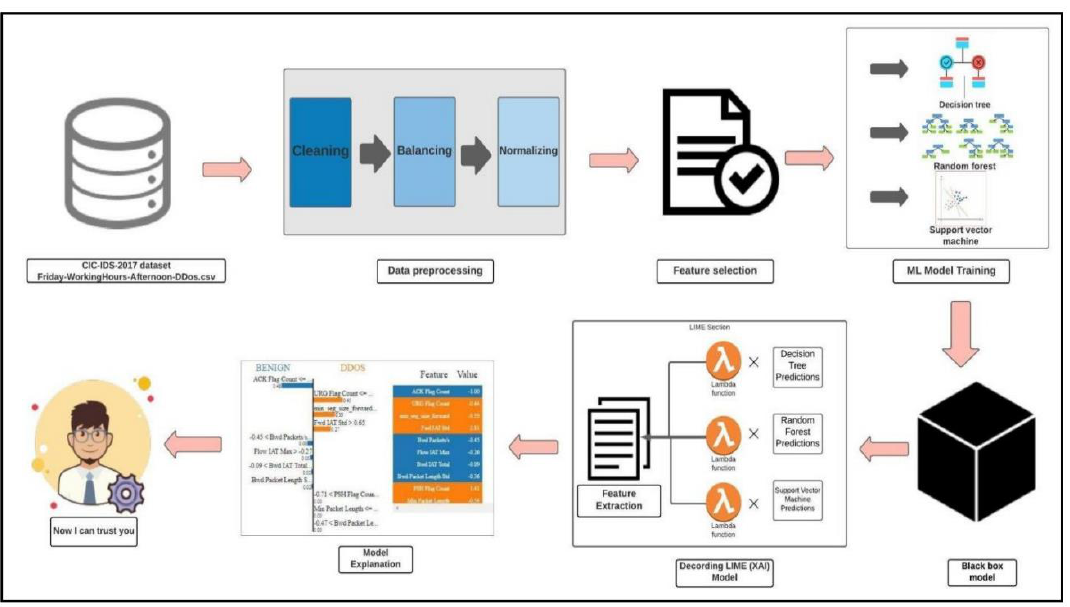
Figure 7. Explainable AI Framework. Creating a LIME explanation.